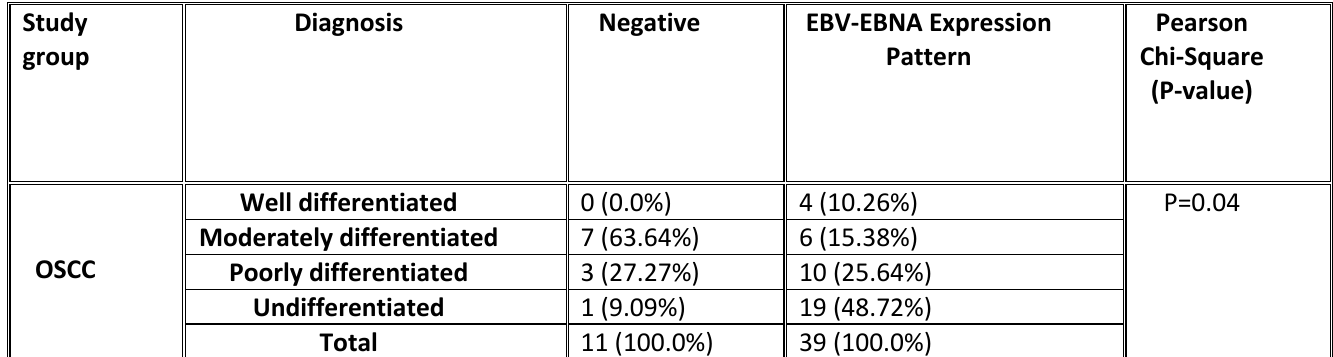
Table 2: EBV prevalence in